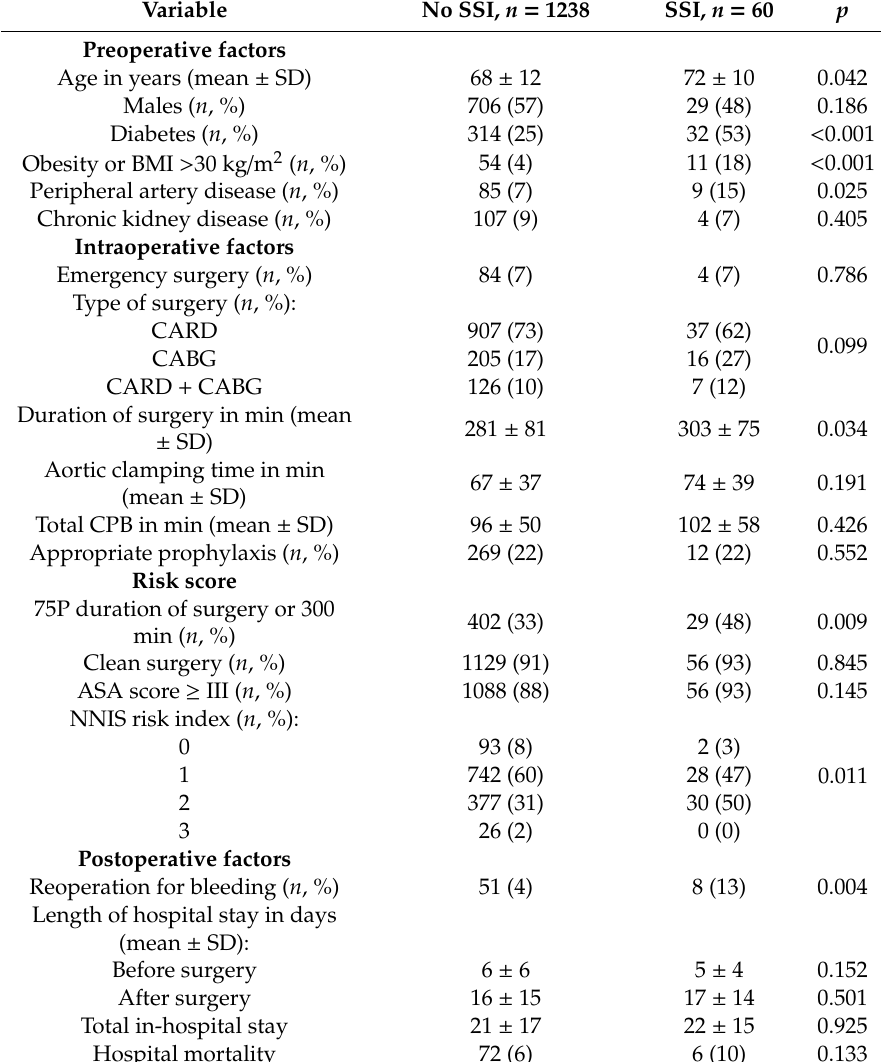
Table 1. Characteristics of study